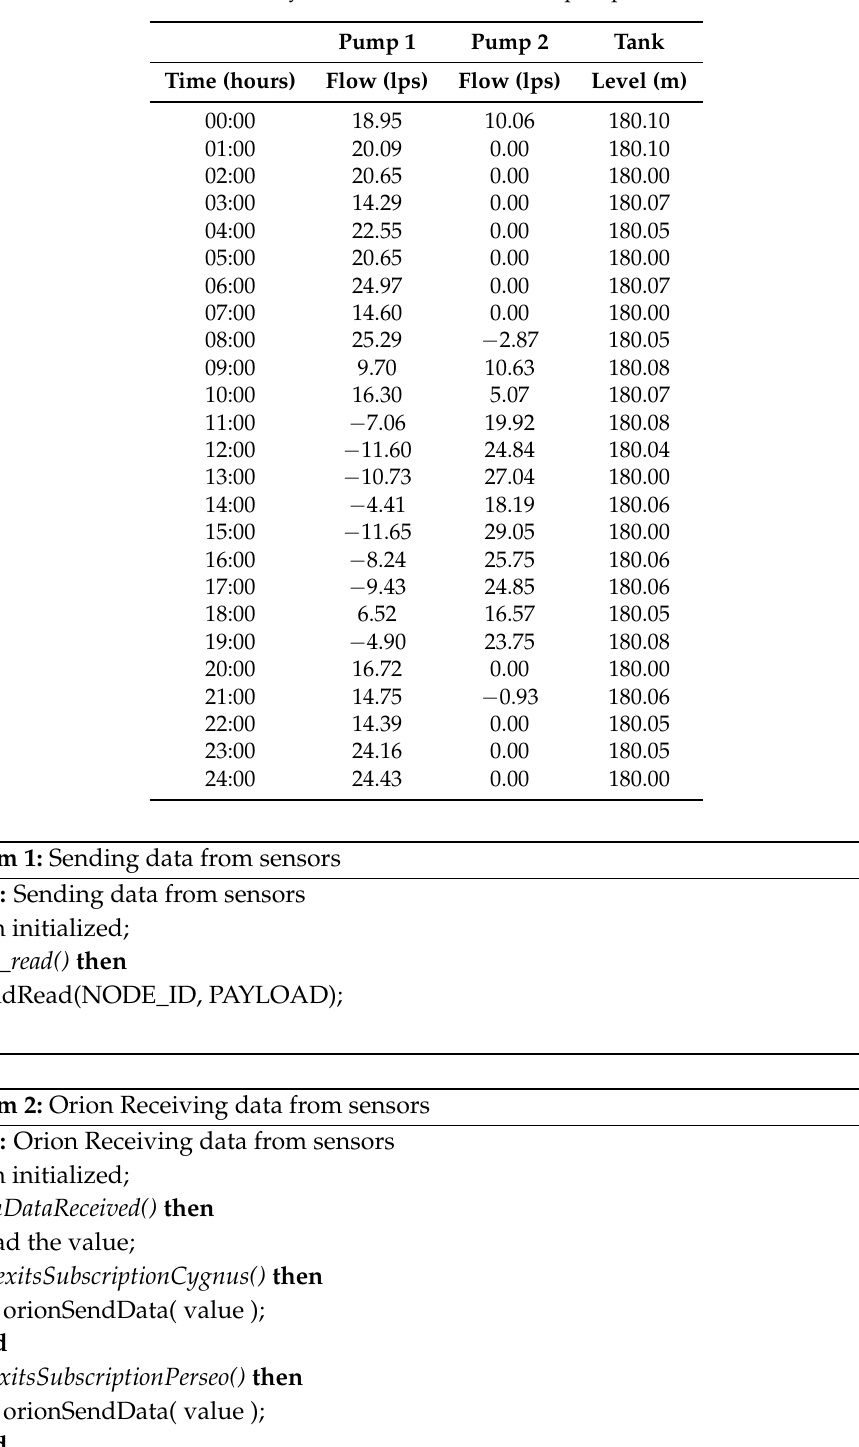
Table 5. Summary of data collected from the pumps and tank.